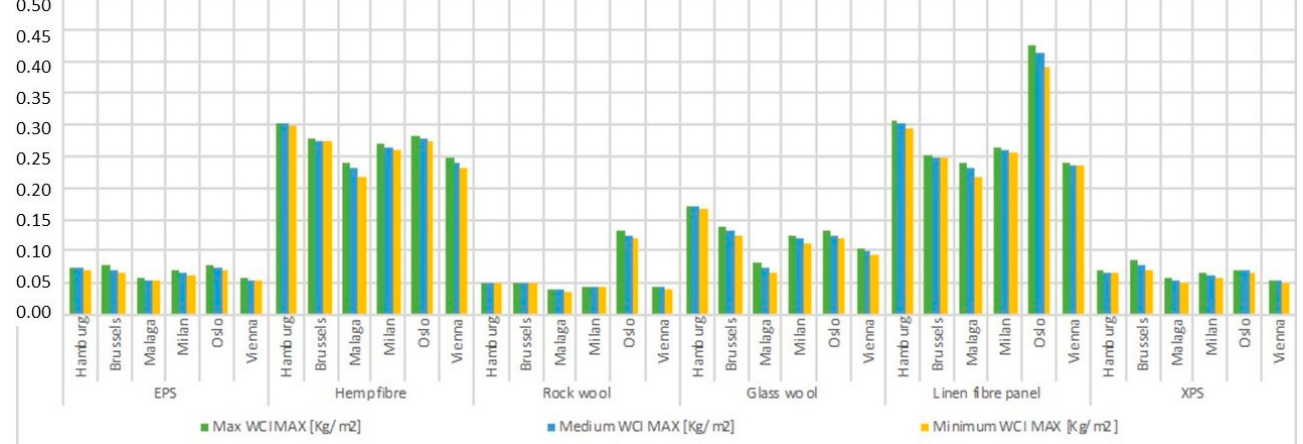
Figure 5. Results of MWCI values, average and minimum (kg/m 2 ), divided by type of insulation and application scenario. Table 5. Results in terms of orientation, location, and type of insulation of the presence or absence of interstitial condensation between the insulation and existing masonry.